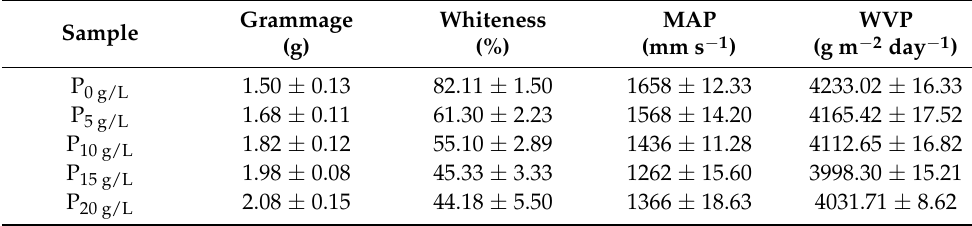
Table 4. Weight, whiteness, MAP, and WVP of untreated co tt on and antimicrobial co tt on.